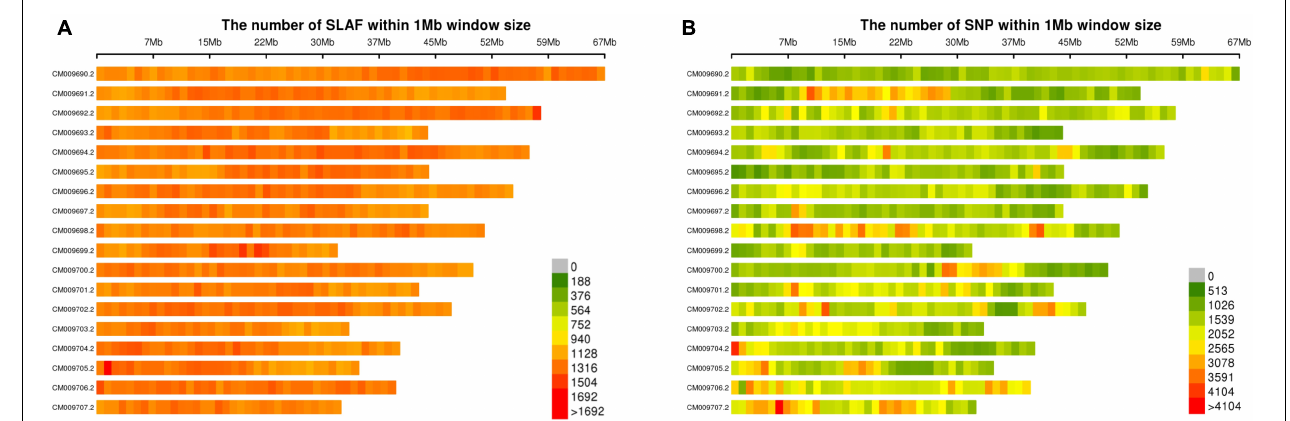
FIGURE 1 | Distribution of SLAF-tags (A) and SNPs (B) on 18 reference chromosomes of broomcorn millet.